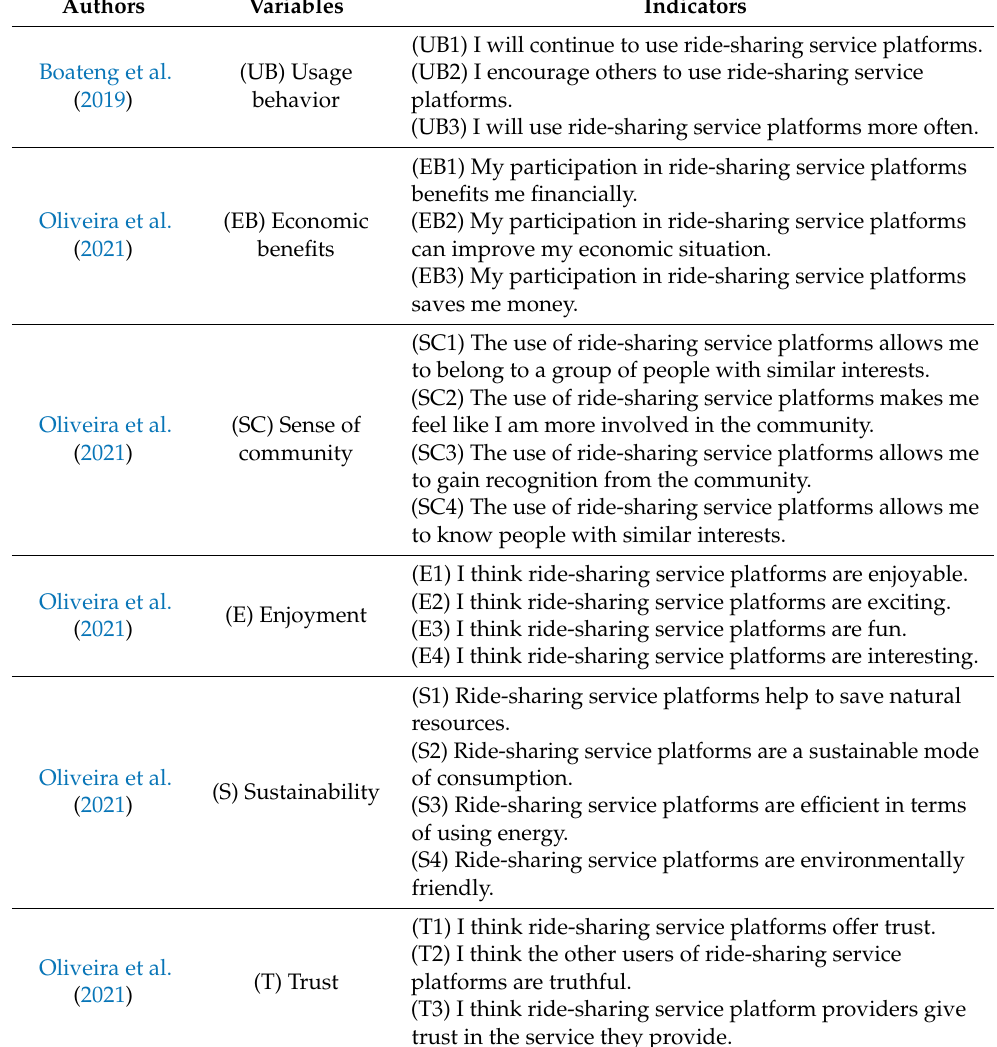
Table 3. Measurement instruments, variables, and